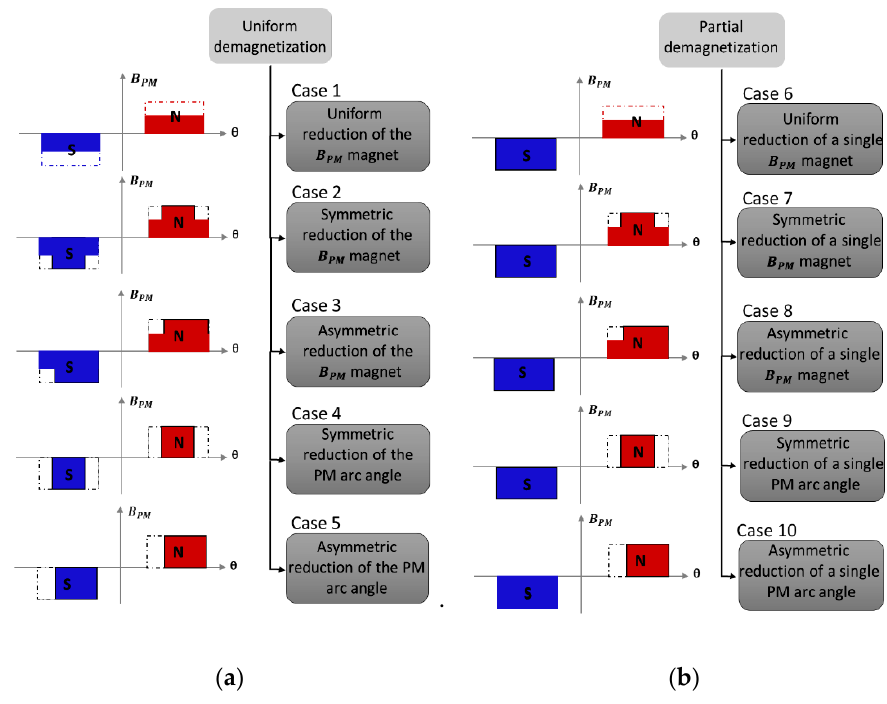
Figure 2. Permanent magnet (PM) demagnetization fault cases description: (a) Uniform demagnetization fault cases description; (b) Partial demagnetization fault cases description.